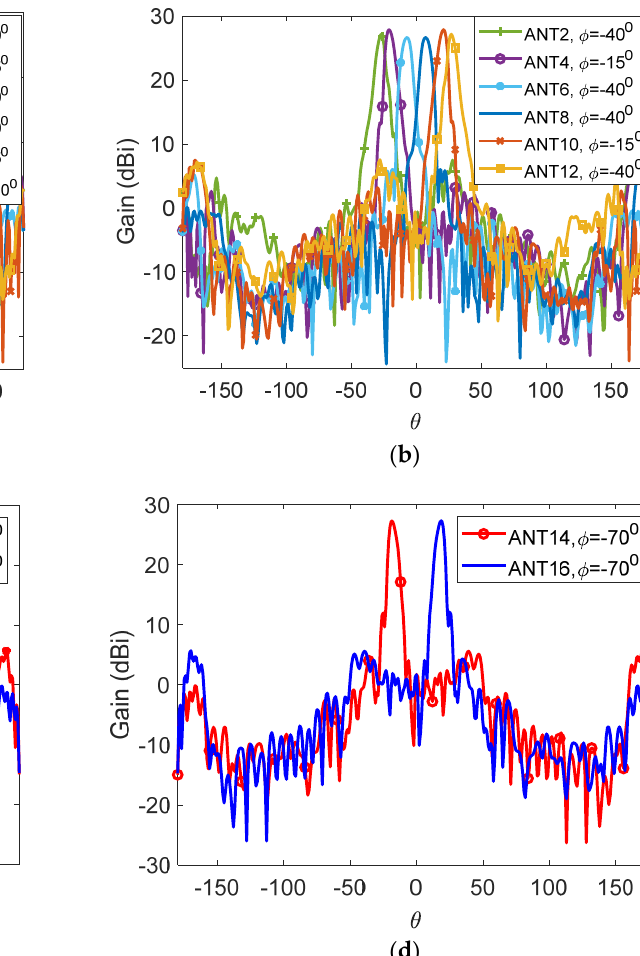
Table 1. The performance of the millimeter ‐ wave beamforming of 16 switchable antennas.